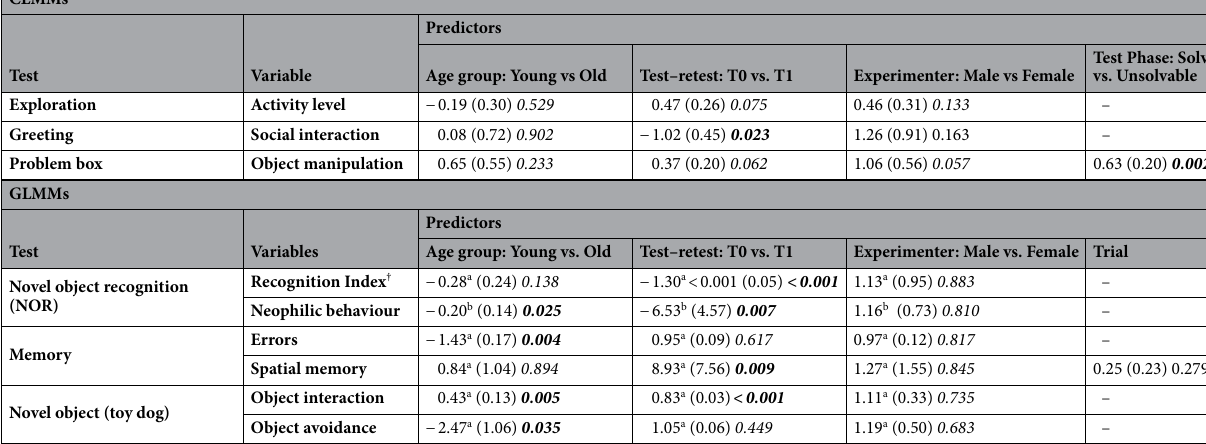
Table 2. The results of three cumulative linked mixed models (CLMMs) and six generalised linear mixed models (GLMMs). For each predictor, the estimate, the standard error (S.E. in brackets), and the p value (in italics) are reported. Significant p values are bolded. a estimate is given as ratio b estimate is given as odds ratio † N = 1 dog (Irisz) was excluded due to a technical issue with the camera The results for the factor’ trial’ are not reported in the model for the variable ‘errors’ because this factor was not retained in the most parsimonious